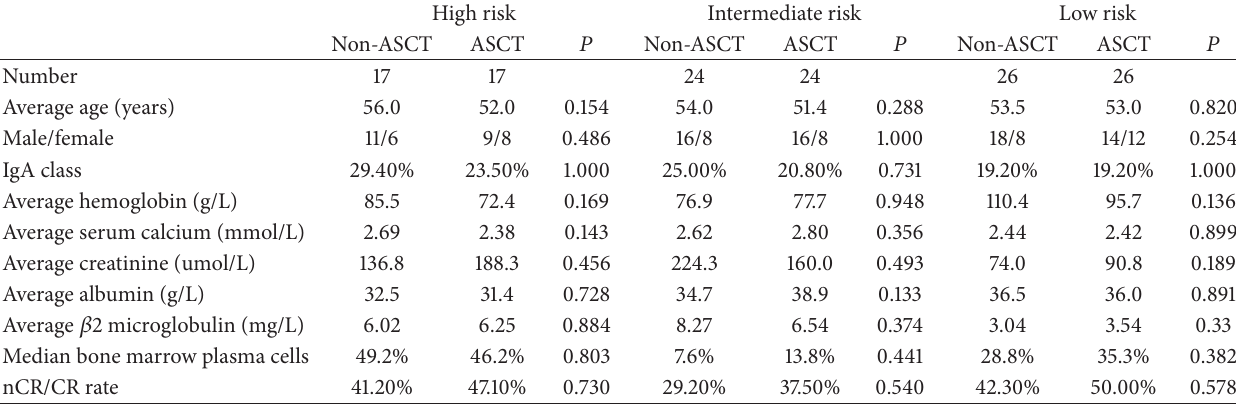
Table 1: Characteristic comparison of MM patients with or without ASCT in three risk